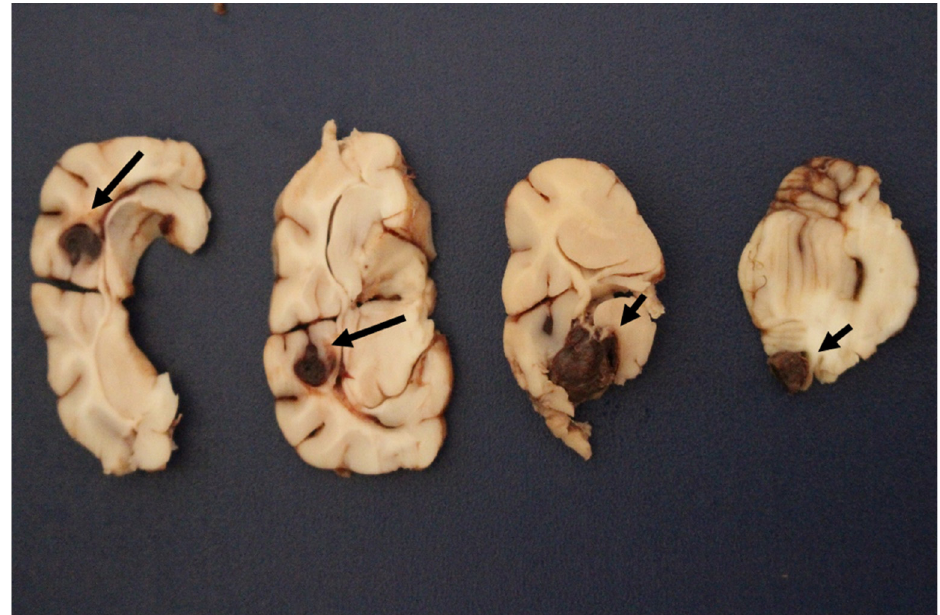
Figure 2. Macroscopic sections of the brain of the kitten. From left to right, hemorrhagic areas were present in the cerebral cortex, corona radiata, diencephalon, and cerebellum (arrows).